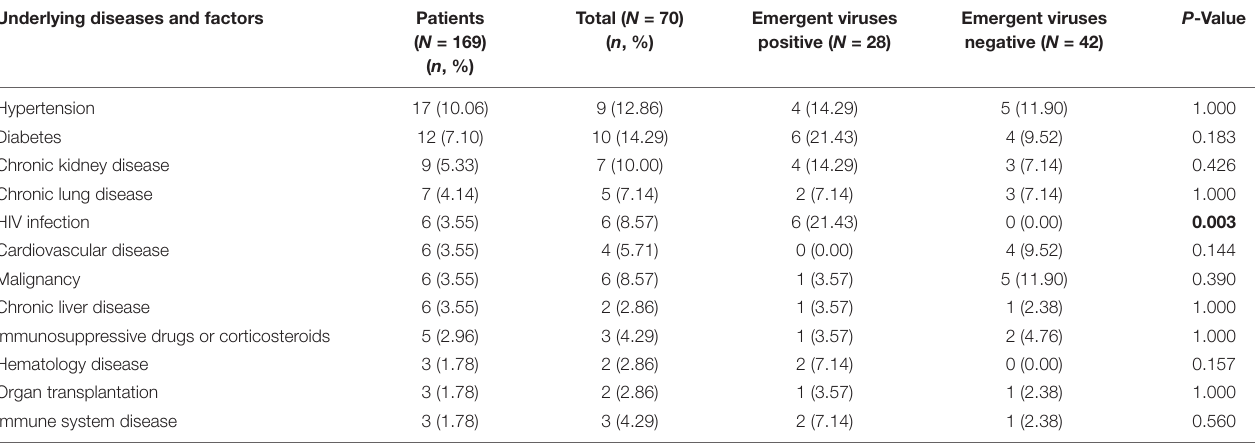
pneumoniae (12/163, 7.36%) and HRV (5/163, 3.07%). The